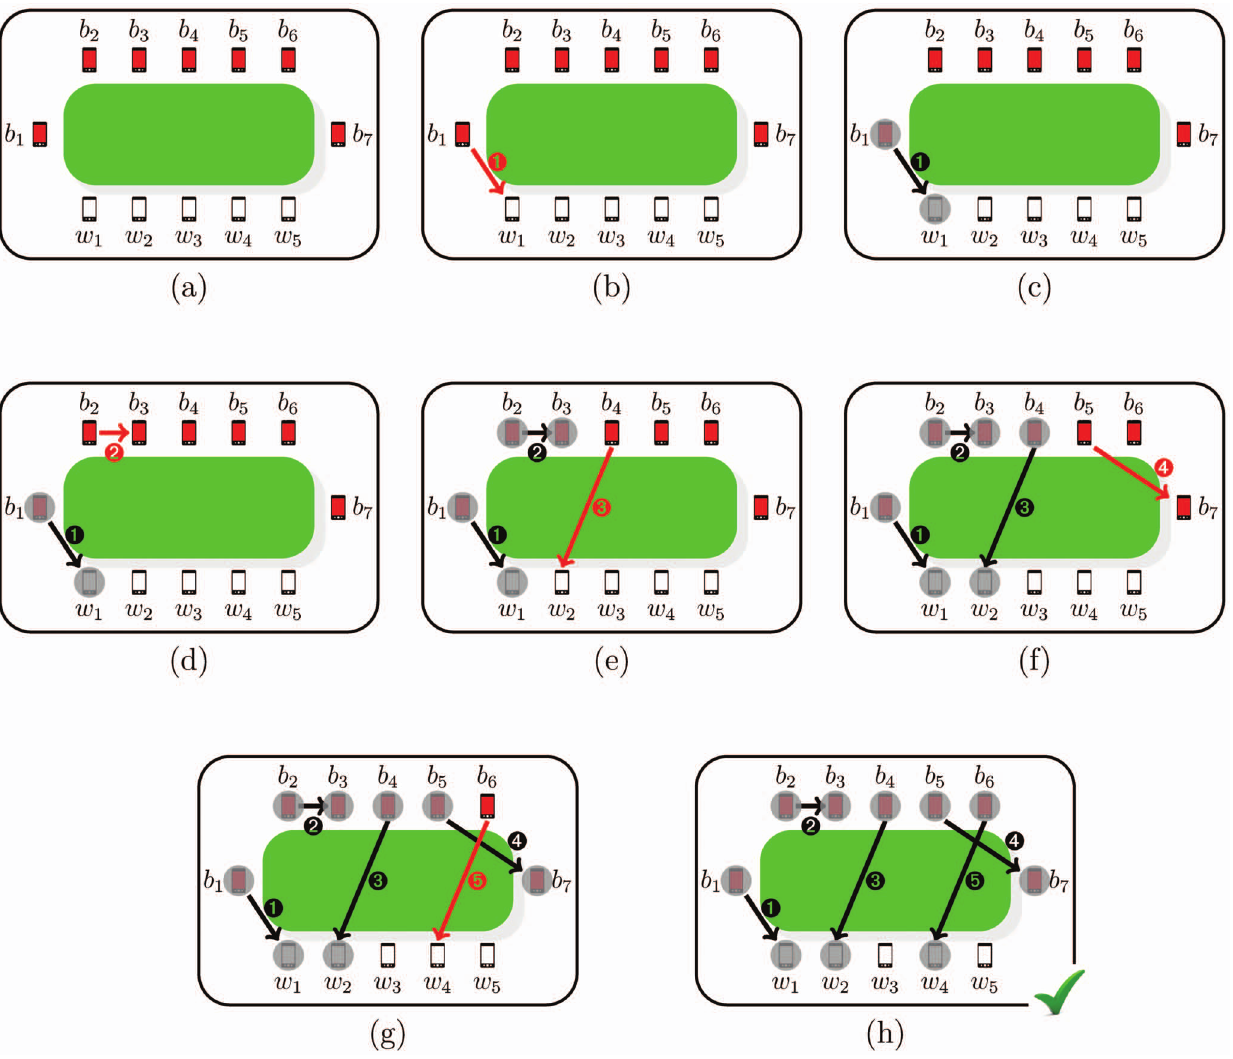
Figure1.Anexampleofmodeldynamicsstartingfromtheinitialconfiguration(7,5). Inred,thepairingthatitisestablishedateachstep.(a)Attime t , I ~ 7 infected mobile phones b 1 , ... , b 7 and S ~ 5 clean mobiles w 1 , ... , w 5 are all within their mutual Bluetooth connection range. (b) b 1 chooses a mobile among b 2 , ... , b 7 , w 1 , ... , w 5 ; it chooses w 1 establishing connection # 1 . (c) Now it b 2 ’s turn to choose, and b 1 and w 1 are not available anymore for pairing (marked by a grey circle # ). (d) b 2 connects to b 3 through pairing # 2 . (e) The two mobiles b 2 and b 3 become unavailable for pairing, too and the next infected mobileinline b 4 pairsto w 2 via # 3 .(f)Only b 6 , b 7 and w 3 , w 4 , w 5 remainavailableforpairingwith b 5 ,whichchooses b 7 (connection # 4 ).(g)Nowthelastmobile b 6 must connect to the remaining unpaired clean phones w 3 , w 4 , w 5 : it chooses w 4 creating pairing # 5 . (h) There are no more unpaired infected mobiles: the process ends at time t z D t . doi:10.1371/journal.pone.0059468.g001 PLOS ONE |